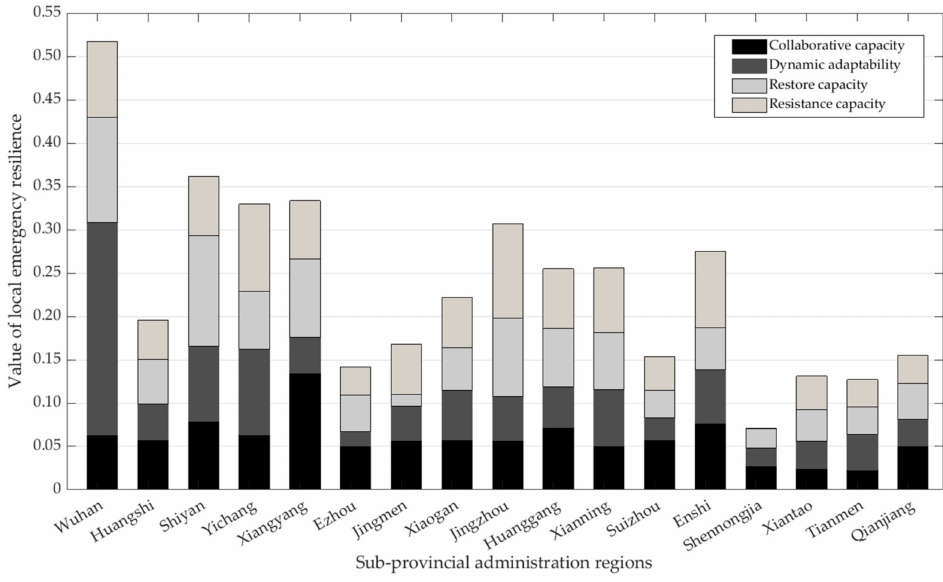
Figure 10. Value of local emergency resilience in four